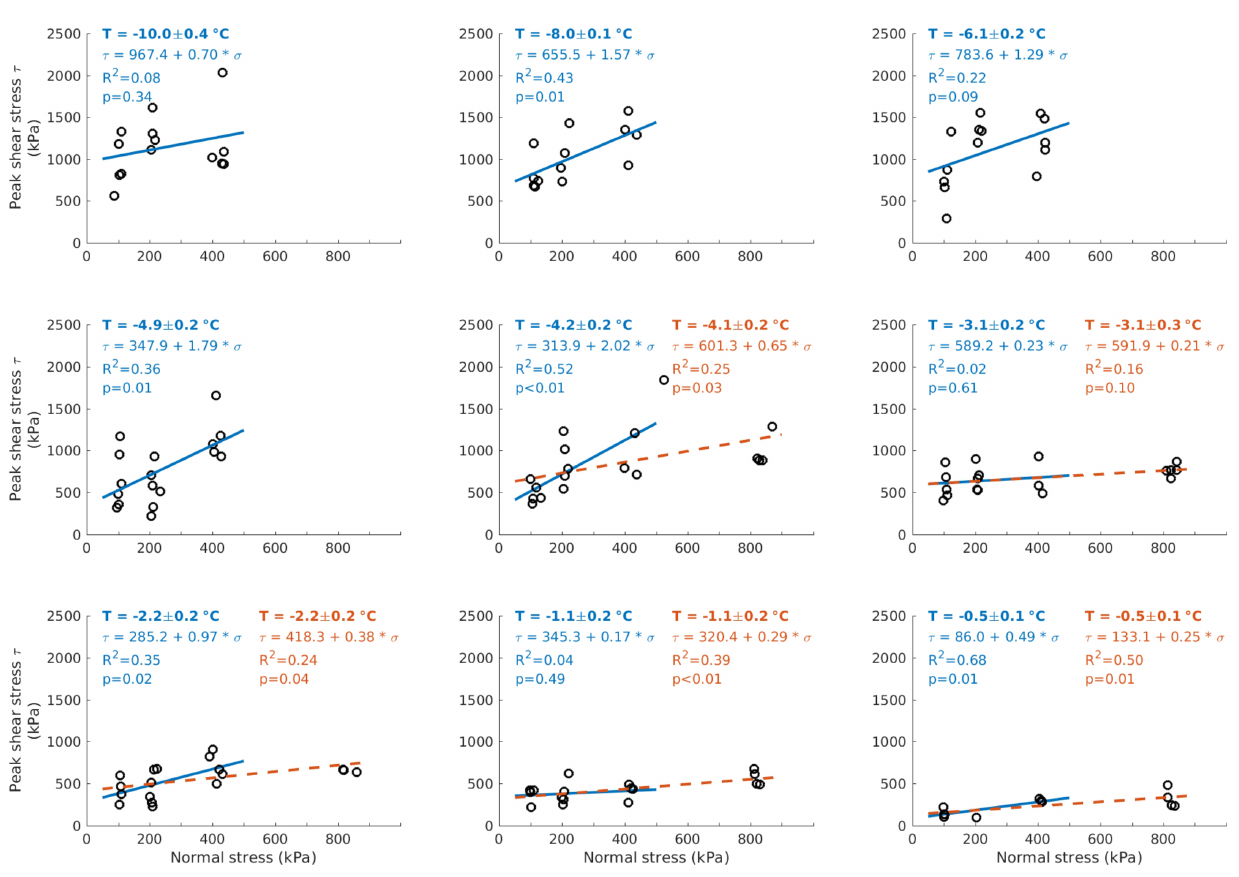
Figure 6. Measured shear stress at failure as a function of normal stress for temperatures between − 10 and − 0 . 5 ◦ C. The temperature values are the means (including standard deviation) of the measured rock sample temperatures (close to the moment of failure) of all experiments belonging to a specific temperature level. Normal stress levels of 100, 200 and 400kPa were applied for the whole temperature range. The level of 800kPa was additionally tested between − 4 and − 0 . 5 ◦ C. Blue solid lines: calculated regression lines for normal stresses at 100– 400kPa. Orange dashed lines: calculated regression lines for 100–800kPa. p : probability of rejecting the null hypothesis ( H 0 ) although it is